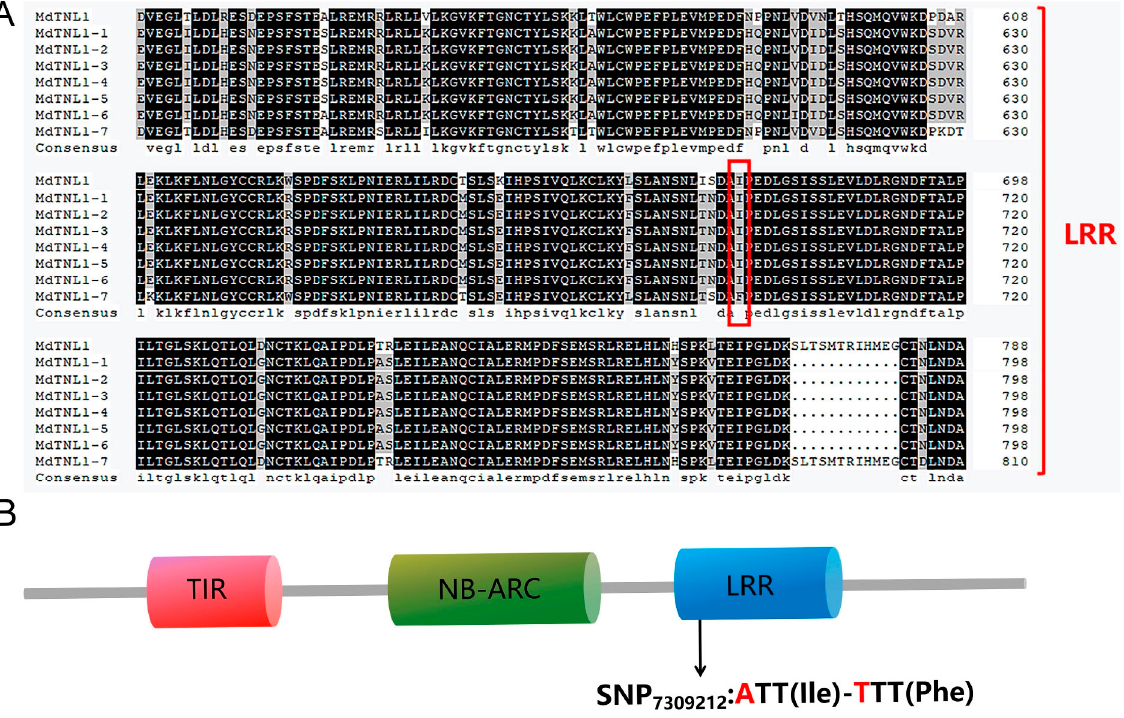
Figure 2. Amino acid sequence and domain constitution of MdTNL1. ( A ) Multiple sequence alignment of LRR domain of MdTNL1 proteins in apple. The red box represents the amino acid of SNP 7309212 . ( B ) Conserved domain of MdTNL1 predicted by SMART.